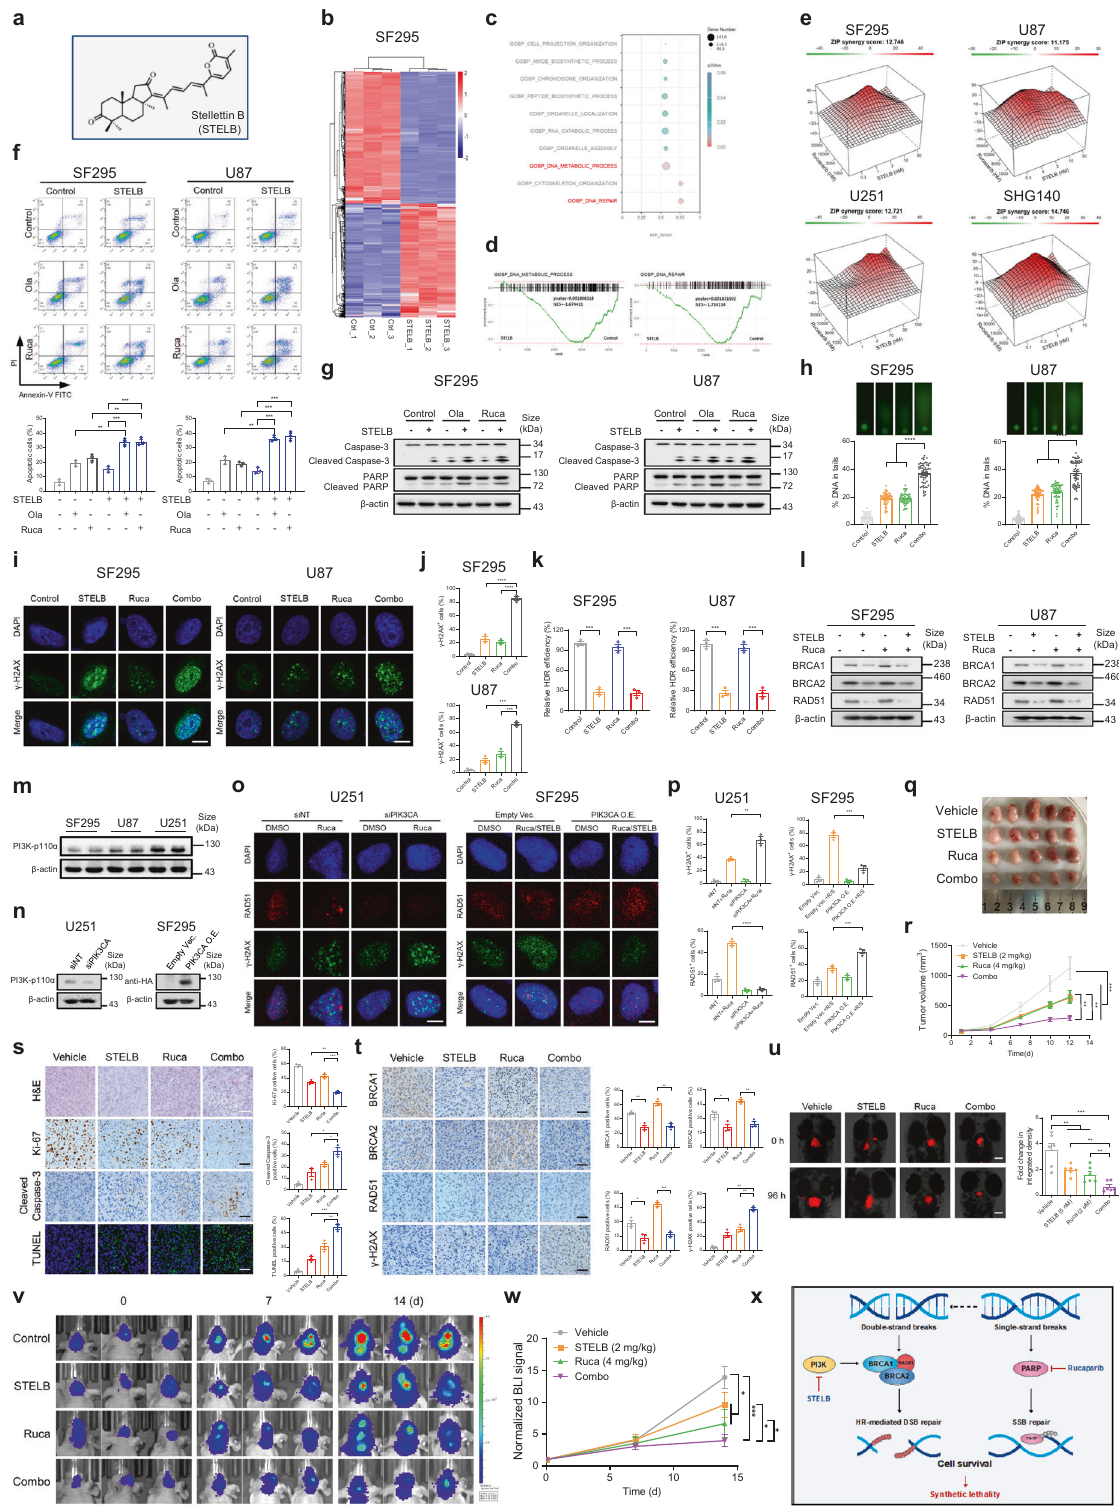
Supplementary Fig. 8c, d). Using immunohistochemistry analysis, we found the combination more signi fi cantly inhibited the abundance of the Ki-67 and augmented apoptosis, as re fl ected by the increase of TUNEL-positive cells and cleavage of